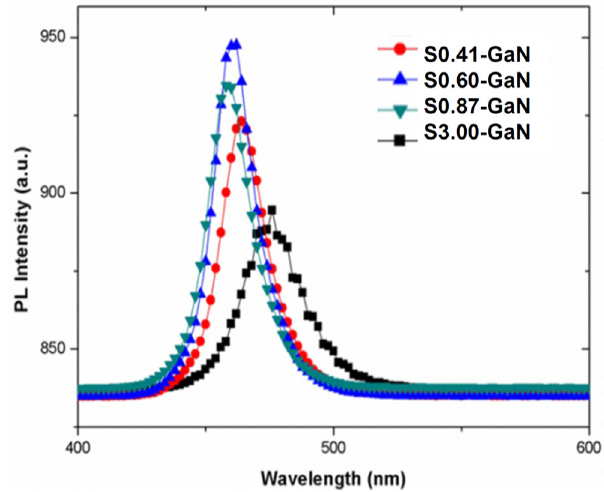
Figure 3. The photoluminescence of muti-quantum-wells grown on